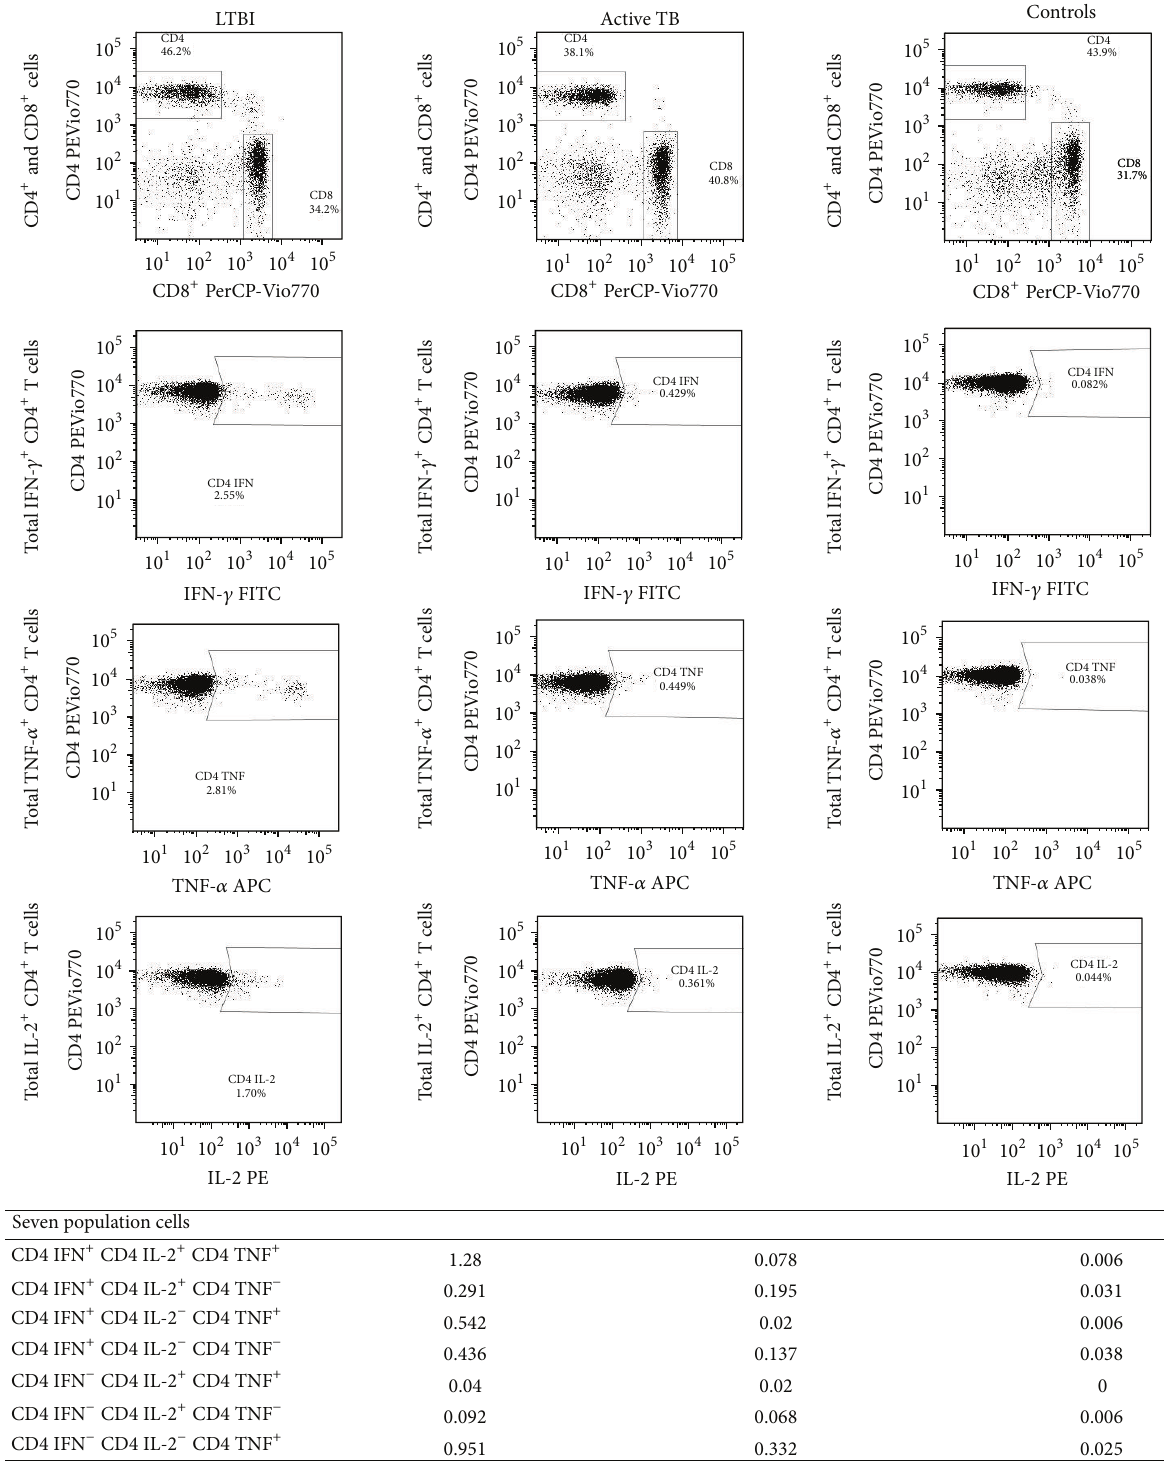
Figure1:Representativeflowcytometry“combinationgates”analysisofCD4 + TcellsofLTBI,activeTB,andcontrolsubjectunderstimulation of TB antigens. Whole blood was analysed using a gating strategy to exclude debris and to identify CD4 + and CD8 + T cells on CD45 + lymphocytes. The subsequent analysis was on CD4 + gate to describe IFN- 𝛾 , IL-2, and TNF- 𝛼 producing T cells. The percentages of the seven different population cells were showed at bottom and were defined in CD4 + cell gate on the basis of total IFN- 𝛾 , IL-2, and TNF- 𝛼 producing